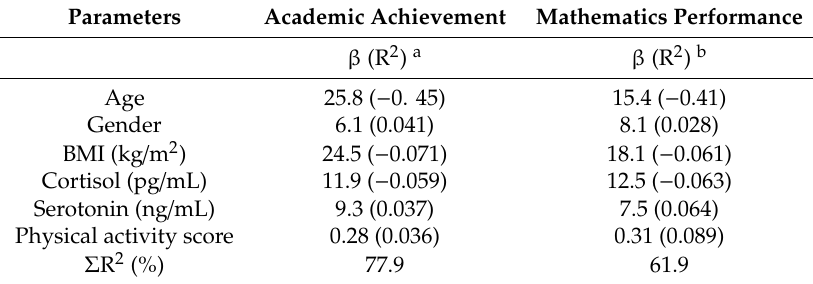
Table 5. Results of stepwise linear regression analysis of academic achievement and mathematics performance predicted by cortisol, serotonin, BMI, and physical activity score among participants (n = 150). Parameters Academic